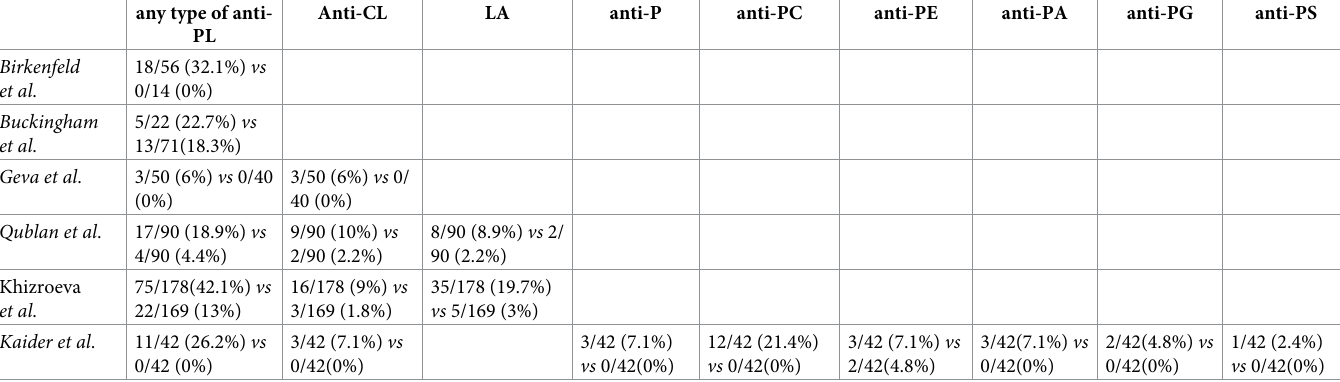
Table 1. Prevalence (reported as percentages in parentheses) of different types of anti-phospholipid (anti-PL) antibodies in studies included in subgroup A of studies. any type of anti-